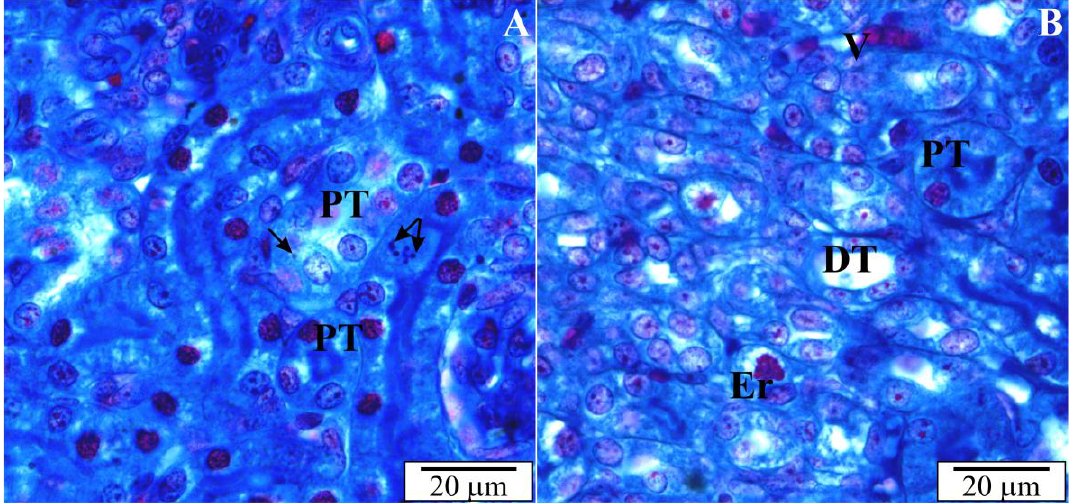
Figure 5 . ( A , B ) Cross sections through the renal cortex of a rat with congenital babesiosis. DT— distal tubules, Er—erythrocytes inside the intermediate tubule, PT—proximal tubules, V—blood vessel, arrows— B. microti merozoites.